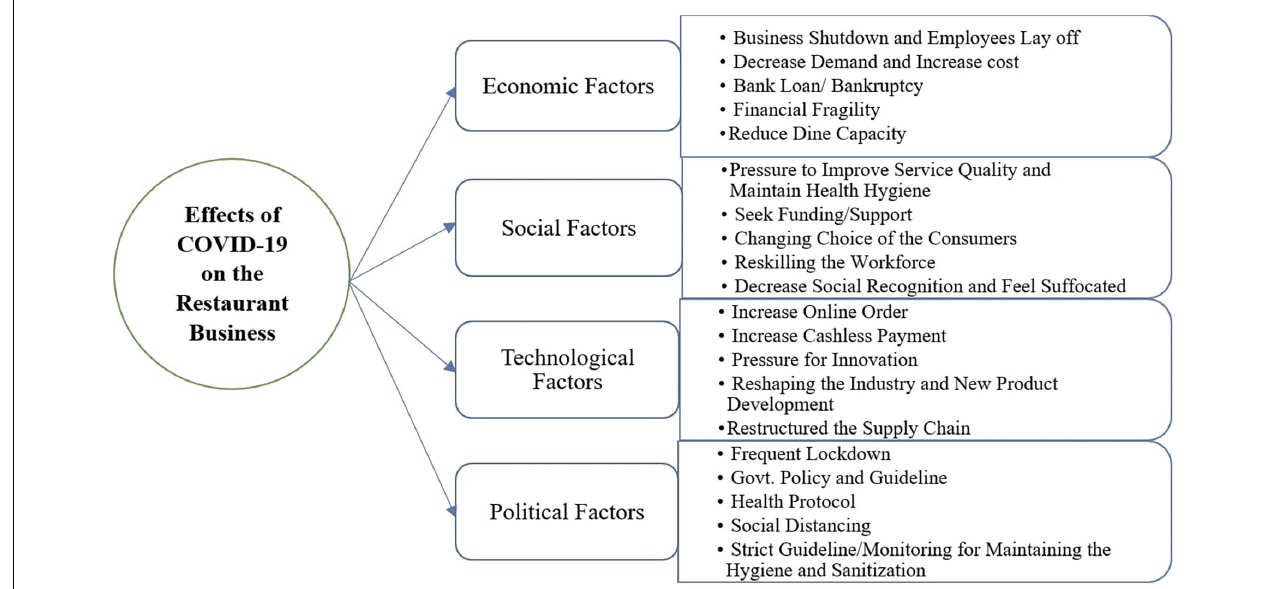
FIGURE 1 | Effects of COVID-19 on the restaurant business.